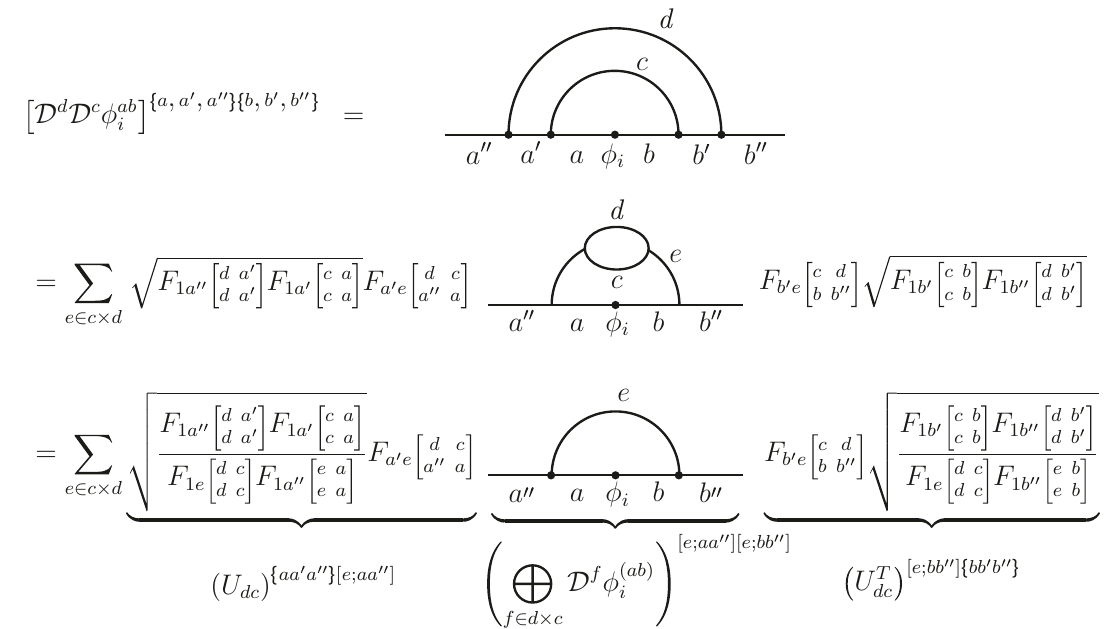
Figure 16 . Defect network manipulations determining the fusion rules of open string